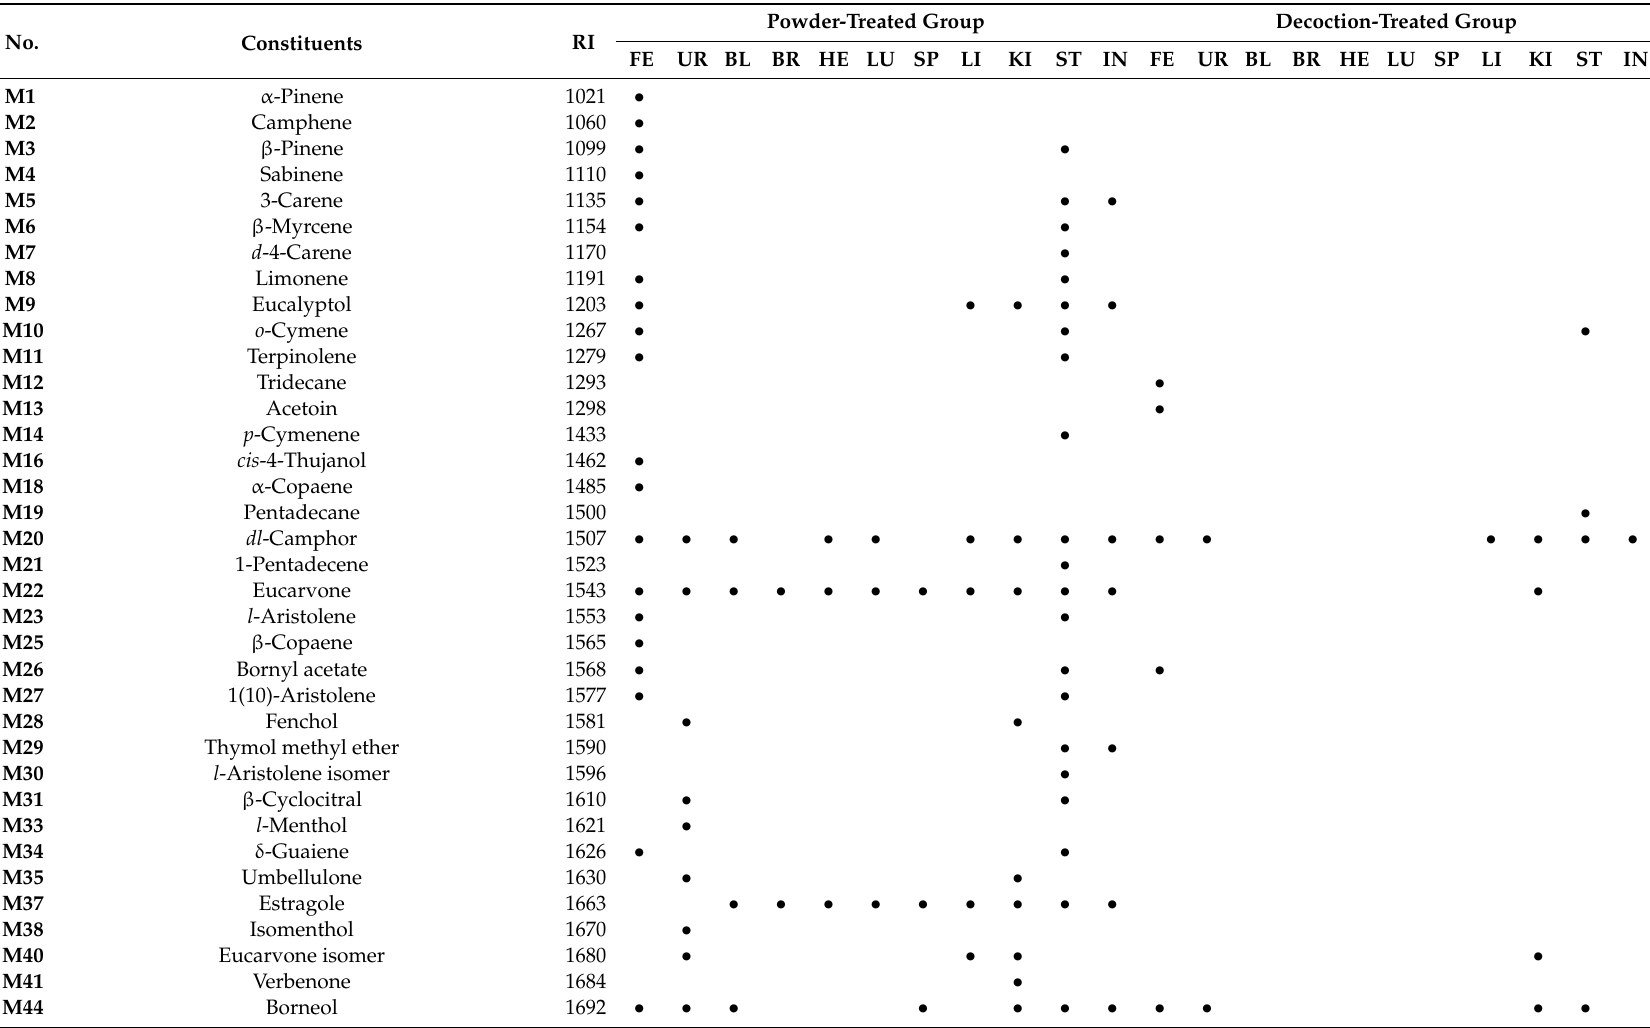
Table 2. Distribution of 101 original constituents in vivo in rats after oral administration of ARR powder or